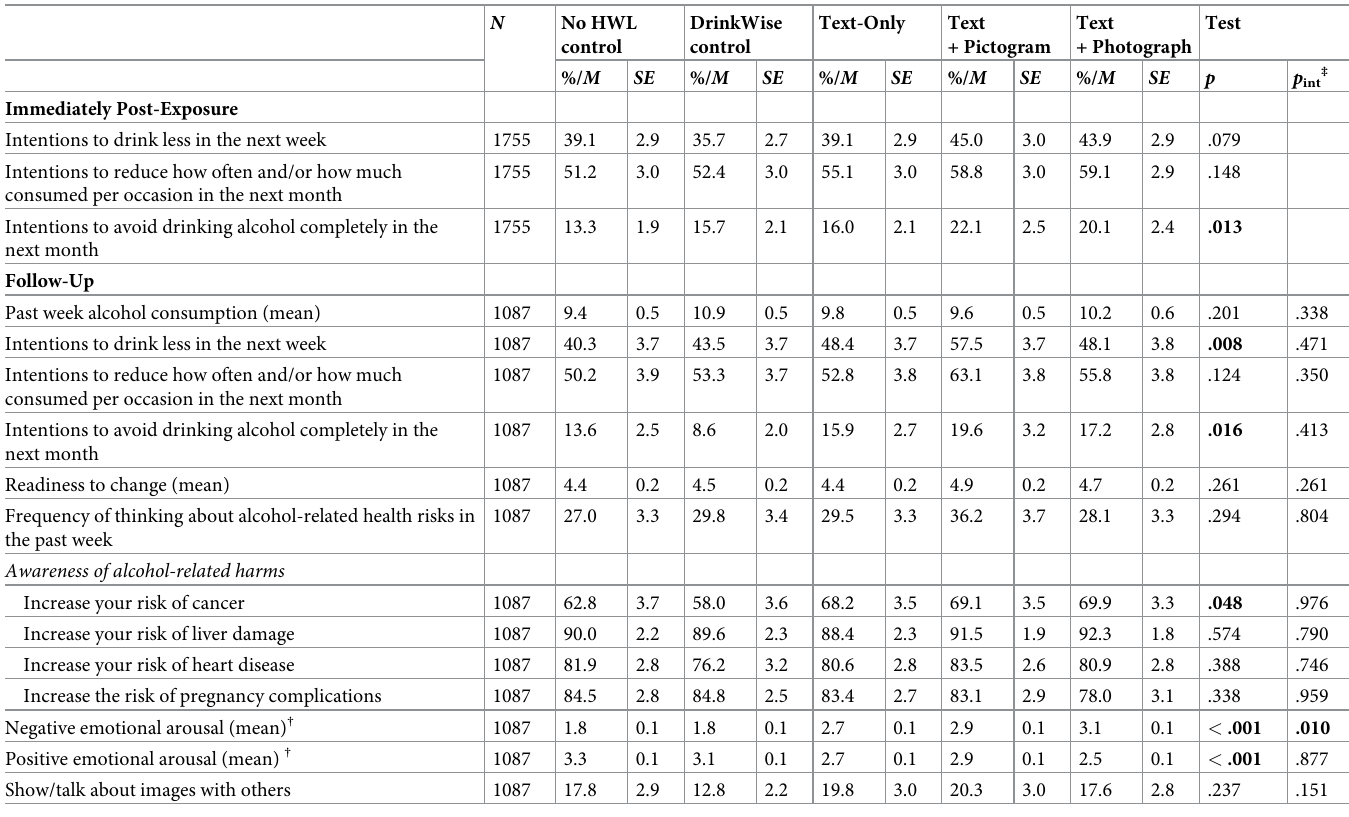
Table 2. Adjusted proportions or means, and omnibus test results for condition or condition-by-dose interaction regression